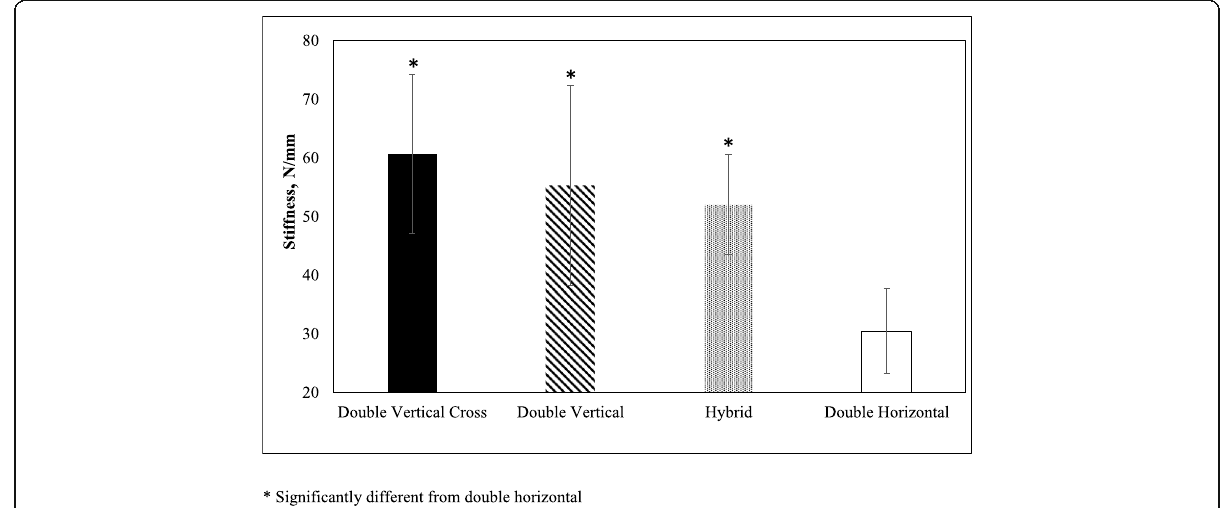
Fig. 4 Stiffness depicted for all four repair groups. * Significantly different from double